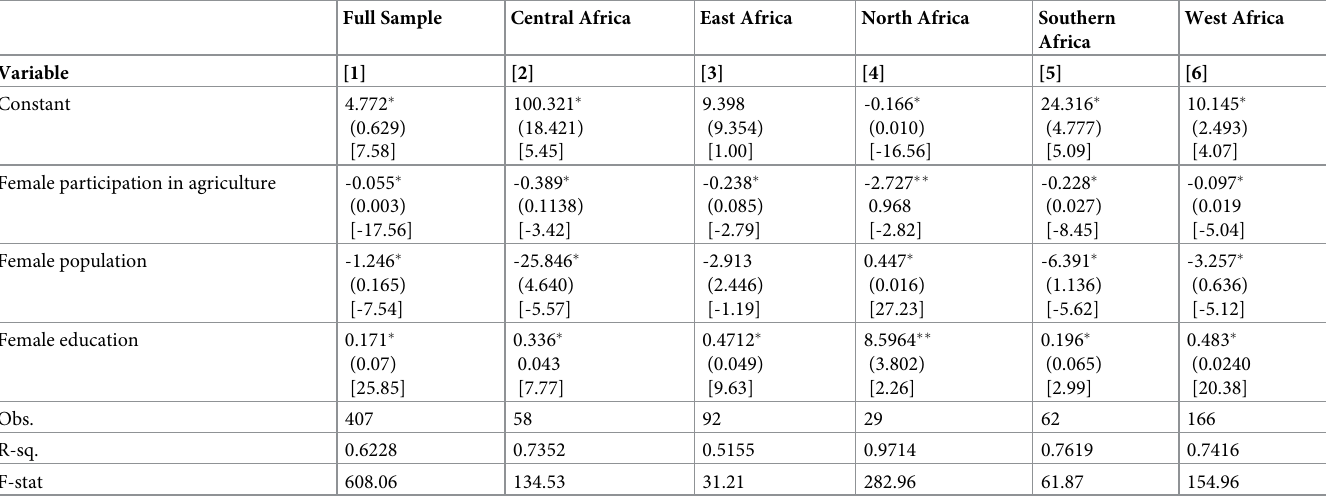
Table 3. Estimates from the pooled ordinary least squares